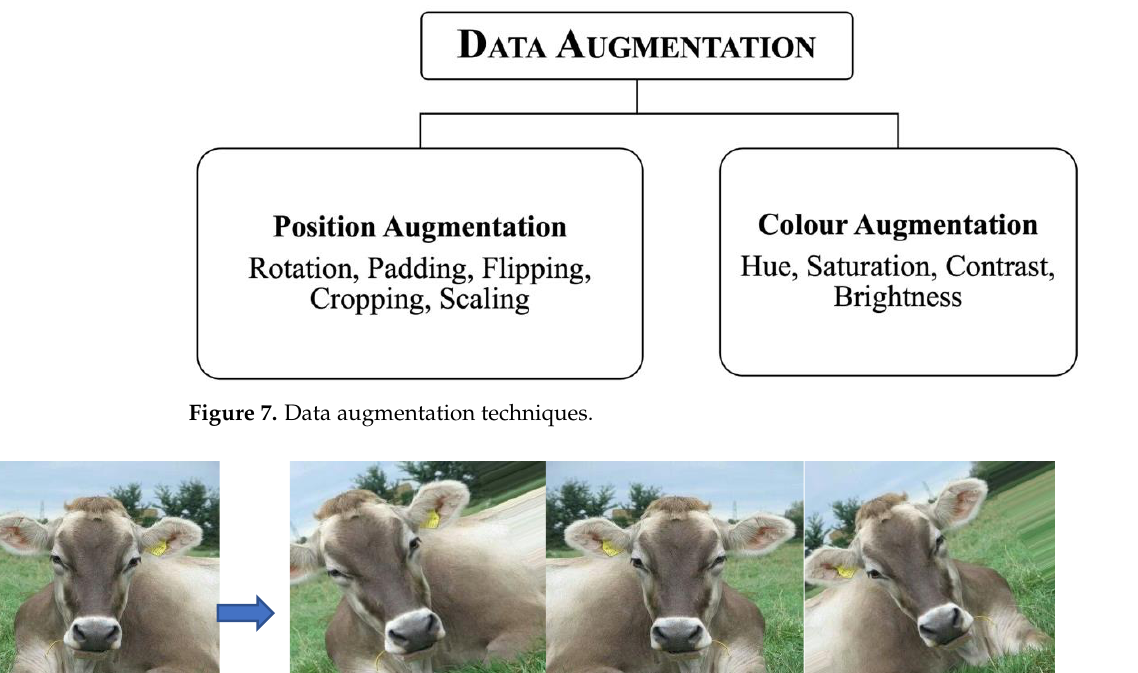
Figure 6. Training phase.